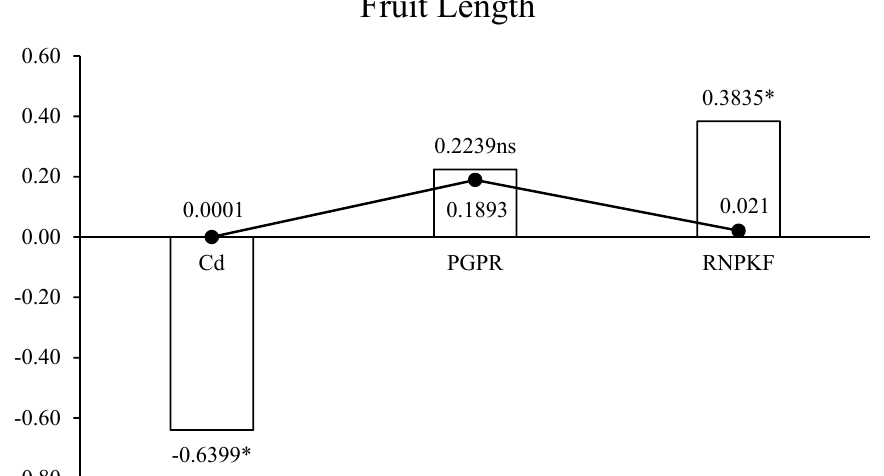
Figure 5. Pearson correlation of Cd, PGPRs, and RNPKF for fruit length (FL). * = significant ( p ≤ 0.05); ns = non ‐ significant.